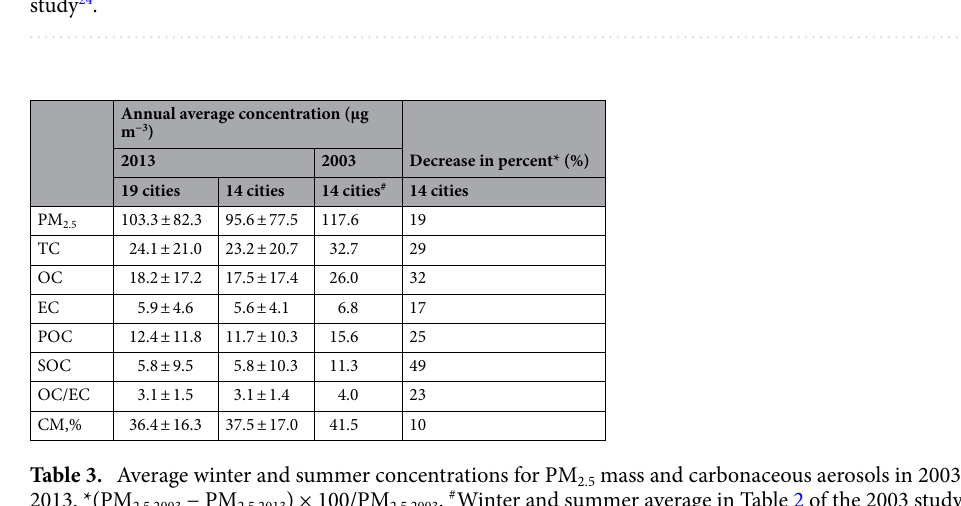
Table 2. Concentrations of OC and EC among 19 cities in 2013. a See site description in Table 1. b Values represent average ± standard deviation in µg m −3 . c CM,carbonaceous matter = 1.6 × OC + EC. d Numbers of samples. e Ave, average for Northern and Southern Cities. *The five sites that ware not included in the 2003 study 24 .